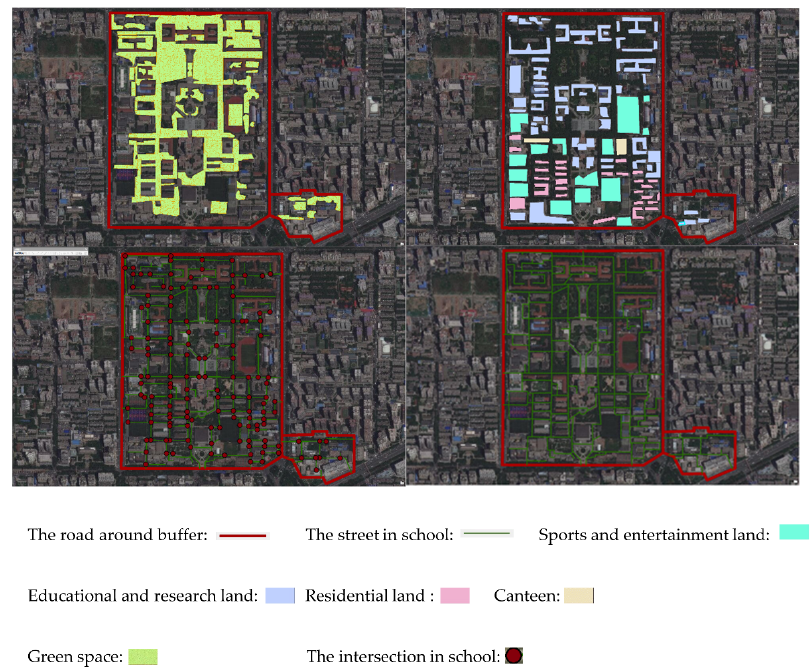
Figure 1. The ArcGis-processed image of one of the colleges.